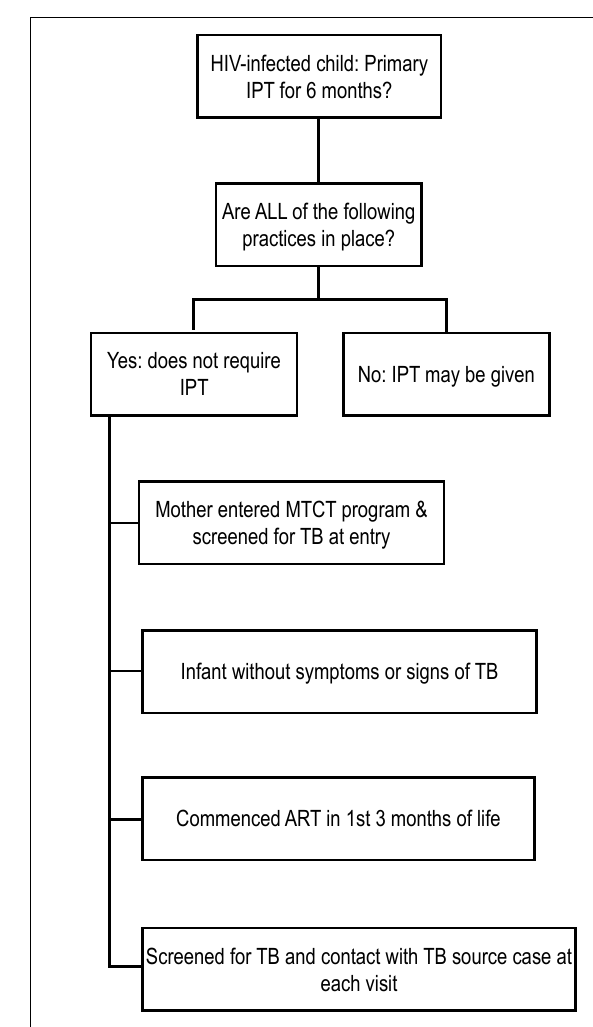
Fig. 2. Considerations for primary (pre-exposure)